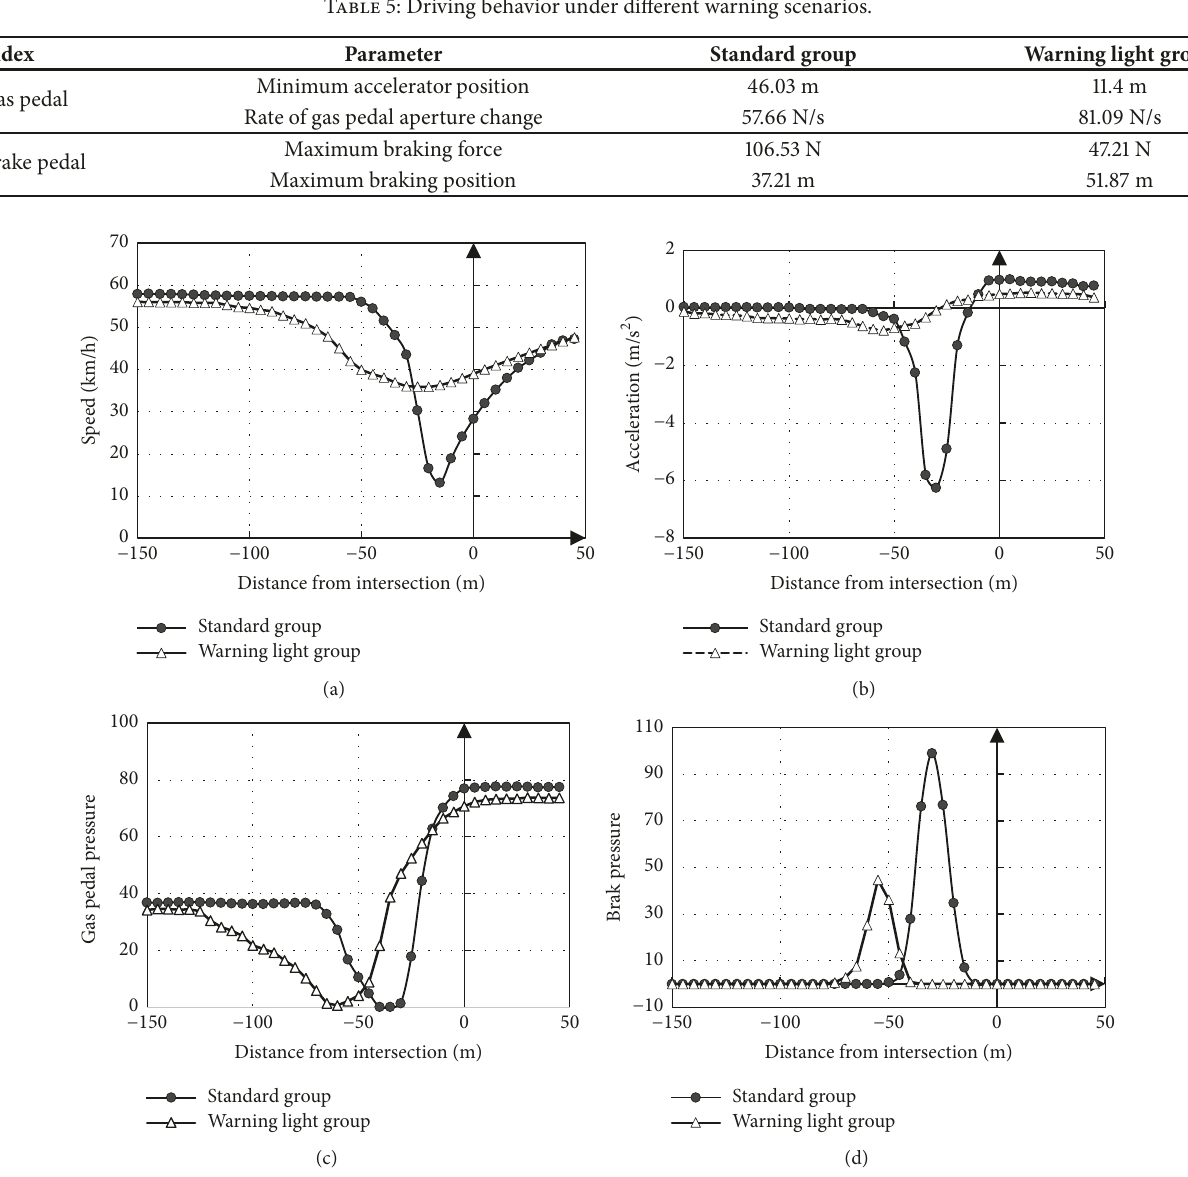
Figure 5: Experiment result: (a) velocity change; (b) acceleration change; (c) gas pedal change; (d) brake pedal